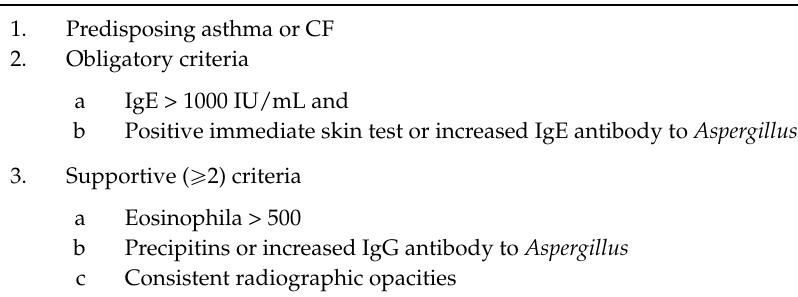
Table 2. Modified ISHAM working group 2013 criteria for diagnosis of ABPA [32].